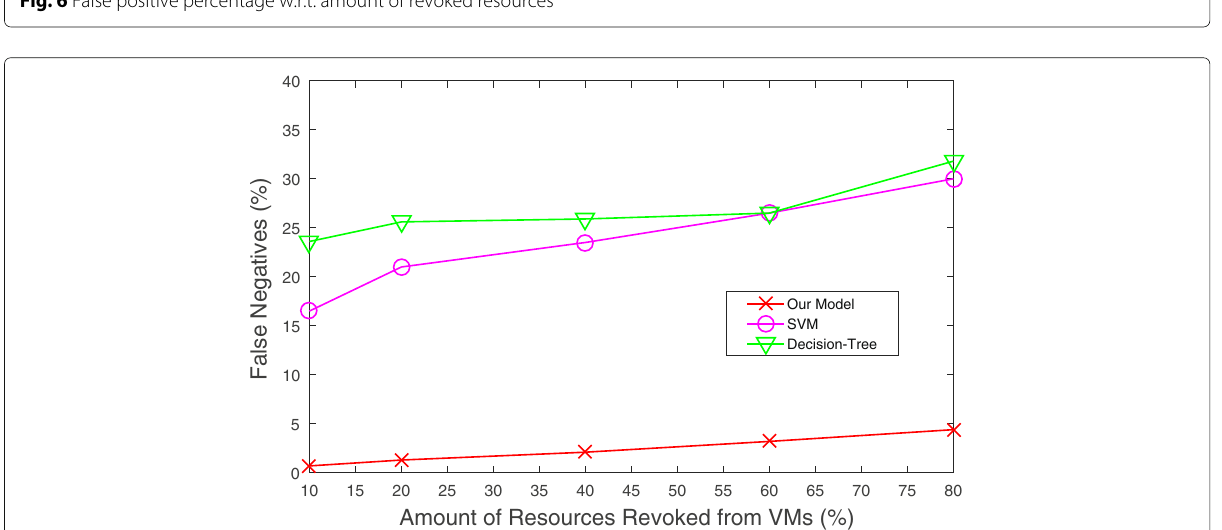
Fig. 6 False positive percentage w.r.t. amount of revoked resources